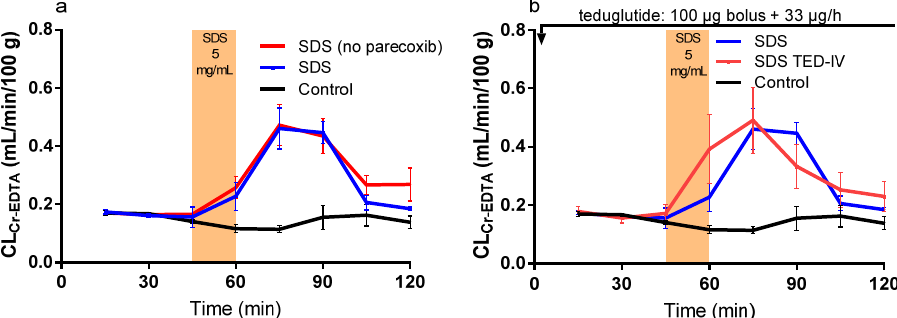
Figure 1. The blood-to-lumen 51 Cr-EDTA clearance (CL Cr-EDTA ) between 0 and 120 min for the control buffer solution with or without sodium dodecyl sulfate (SDS) at 5 mg/mL added to the luminal perfusate between 45 and 60 min. ( a ) The effect of intravenously pretreating rats with 10 mg/kg parecoxib 30 min before the start of the SDS experiment. ( b ) The effect of intravenously treating rats with a 100 μ g teduglutide bolus at time 0, followed by a 33 μ g/h teduglutide infusion during the whole SDS experiment.